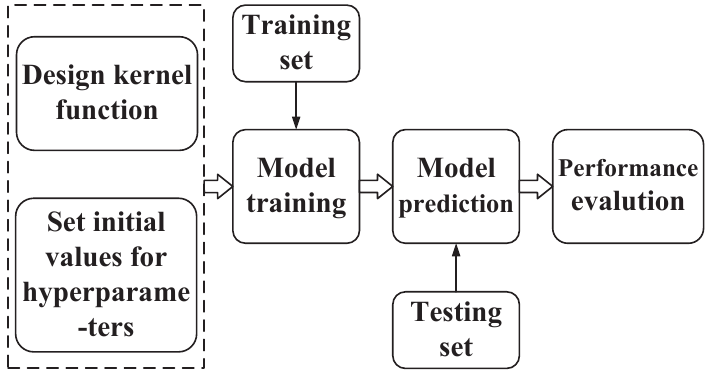
Figure 1. Process of GPR model.